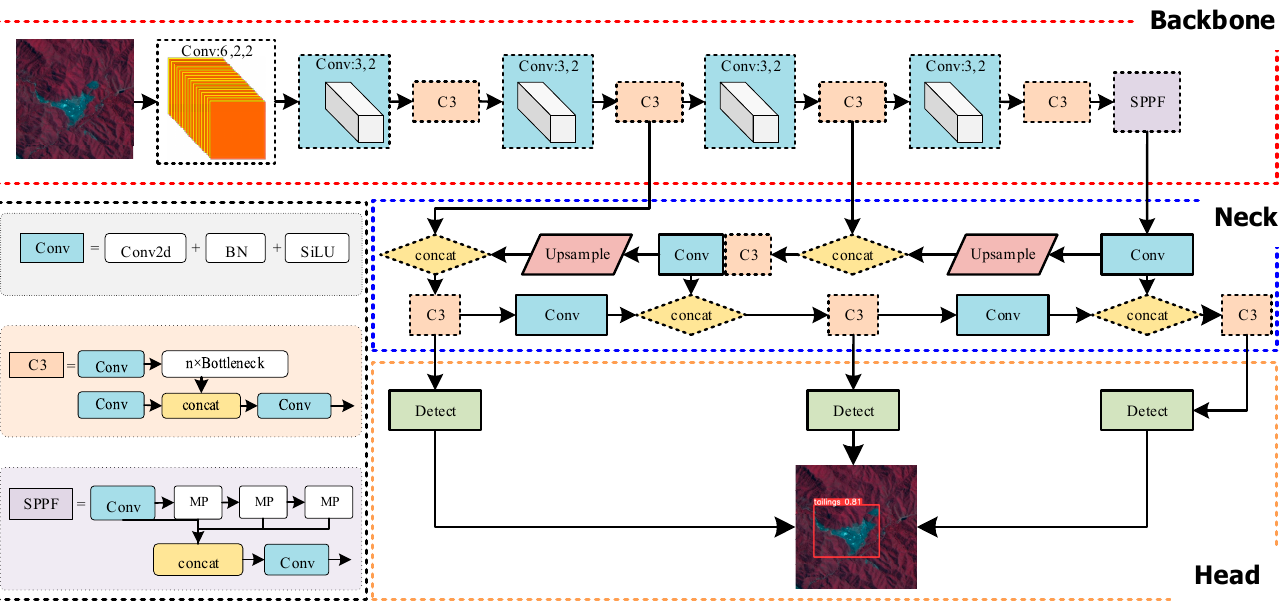
Figure 5. The YOLOv5 network structure.